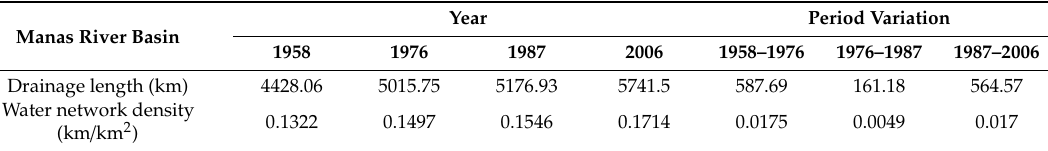
Table 3. Length and density changes of streams in the Manas River Basin from